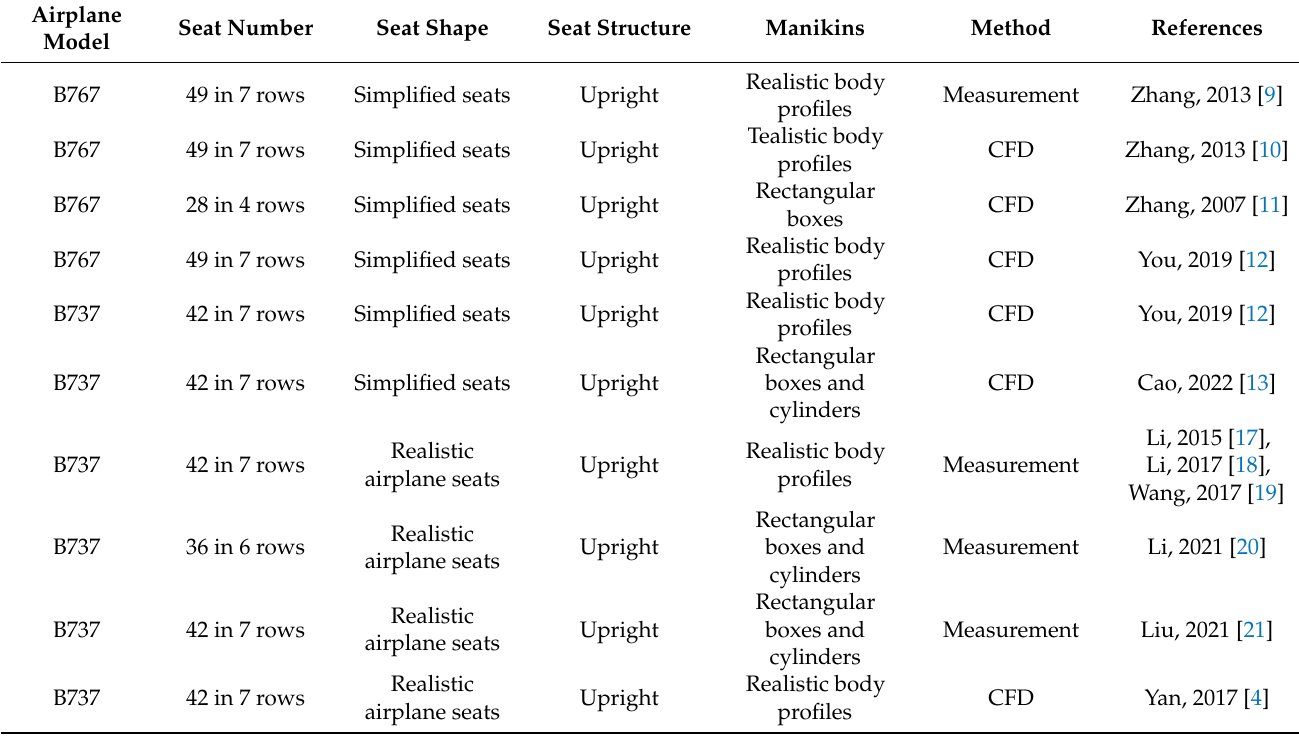
Table 1. Summary of symmetric, upright seat layout and manikins in representative published